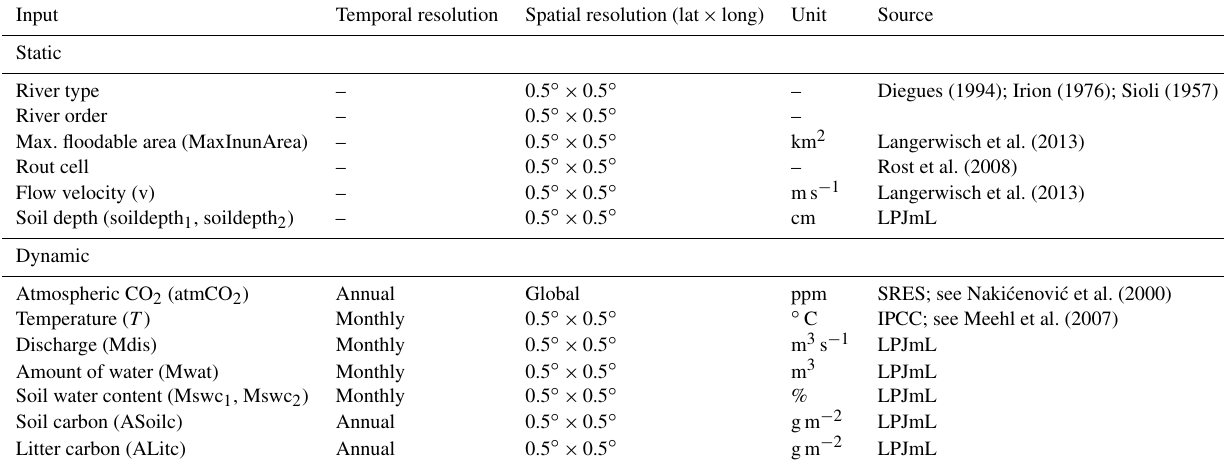
Table 1. Overview of the input used in the model.